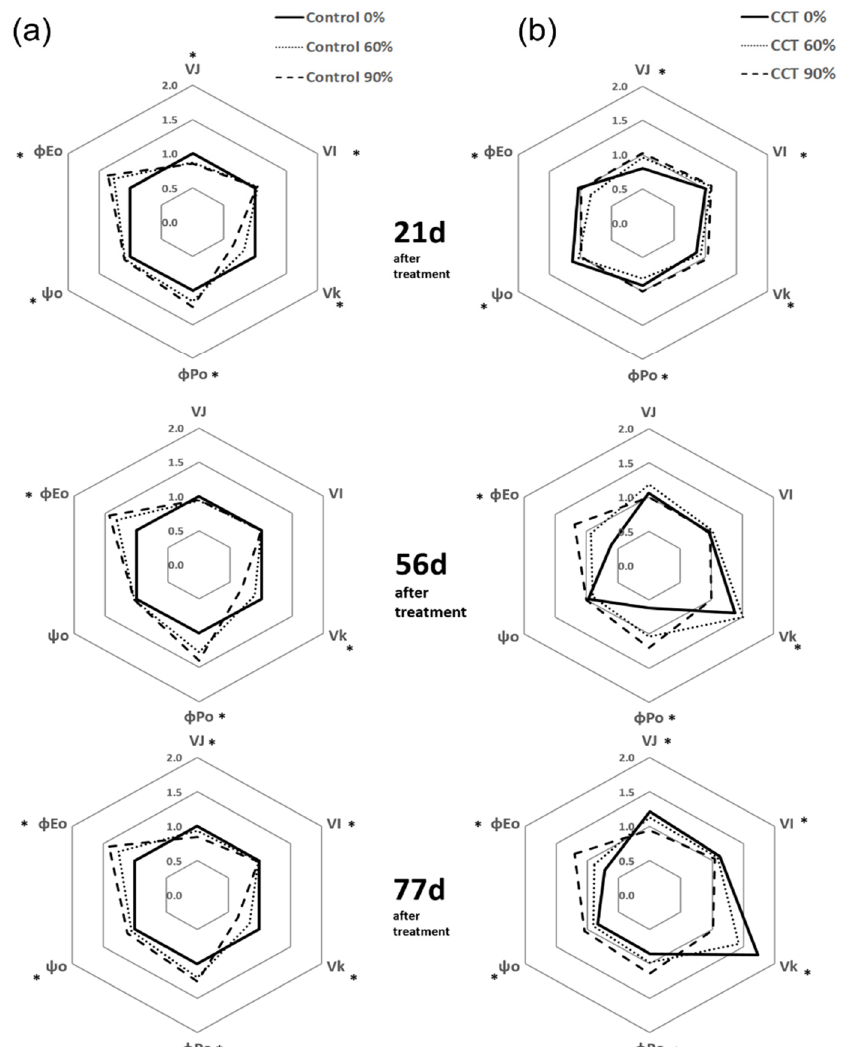
Figure 5. Radar plots of several fluorescence parameters (VJ, VI, Vk, Φ PO, Φ EO, and Ψ O) of Sedirea japonica under control (CO 2 = 400 ppm) ( a ) and CCT (climate change treatment, CO 2 = 650 ppm, temperature = control + 3 °C) ( b ) conditions 21, 56, and 77 days after the treatment. The asterisk indicates significance at p < 0.05.